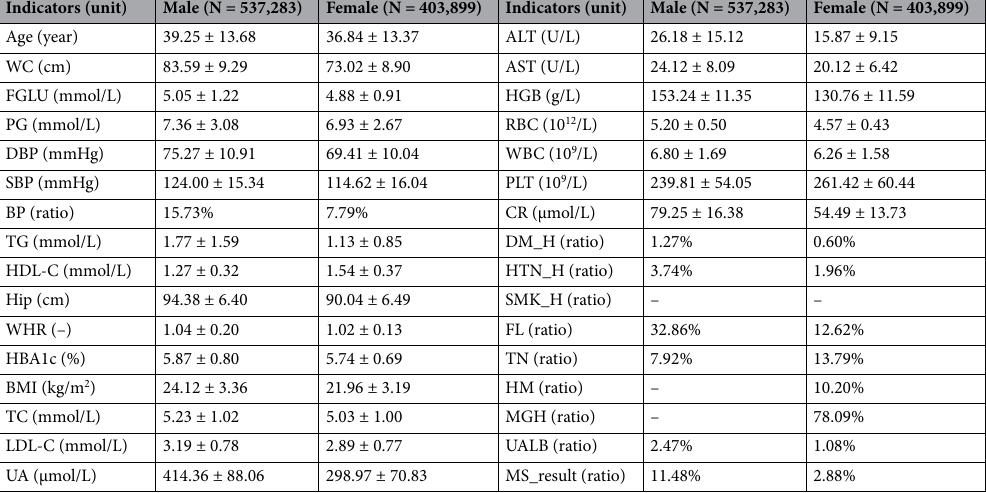
Table 8. Basic statistical characteristics of the raw data set. Continuous indicator is expressed as mean ± standard deviation, discrete indicator is expressed as a percentage (%). MS_result is the numerical result of MetS, the value is 0 or 1, 0 represents no disease, 1 represents disease. – means less than 0.1% of the data is available due to missing or gender specific examinations. ALT, alanine aminotransferase; AST, aspartate aminotransferase; CR, creatinine; DM_H, history of diabetes mellitus; HBA1c, hemoglobin a1c; HM, hysteromyoma; HTN_H, history of hypertension; LDL-C, low-density lipoprotein cholesterol; MGH, mammary gland hyperplasia; N, numbers; PLT, platelets; RBC, red blood cell count; SMK_H, history of smoking; TC, total cholesterol; TN, thyroid nodules; UA, uric acid; UALB, urine albumin; WBC, white blood cell count.